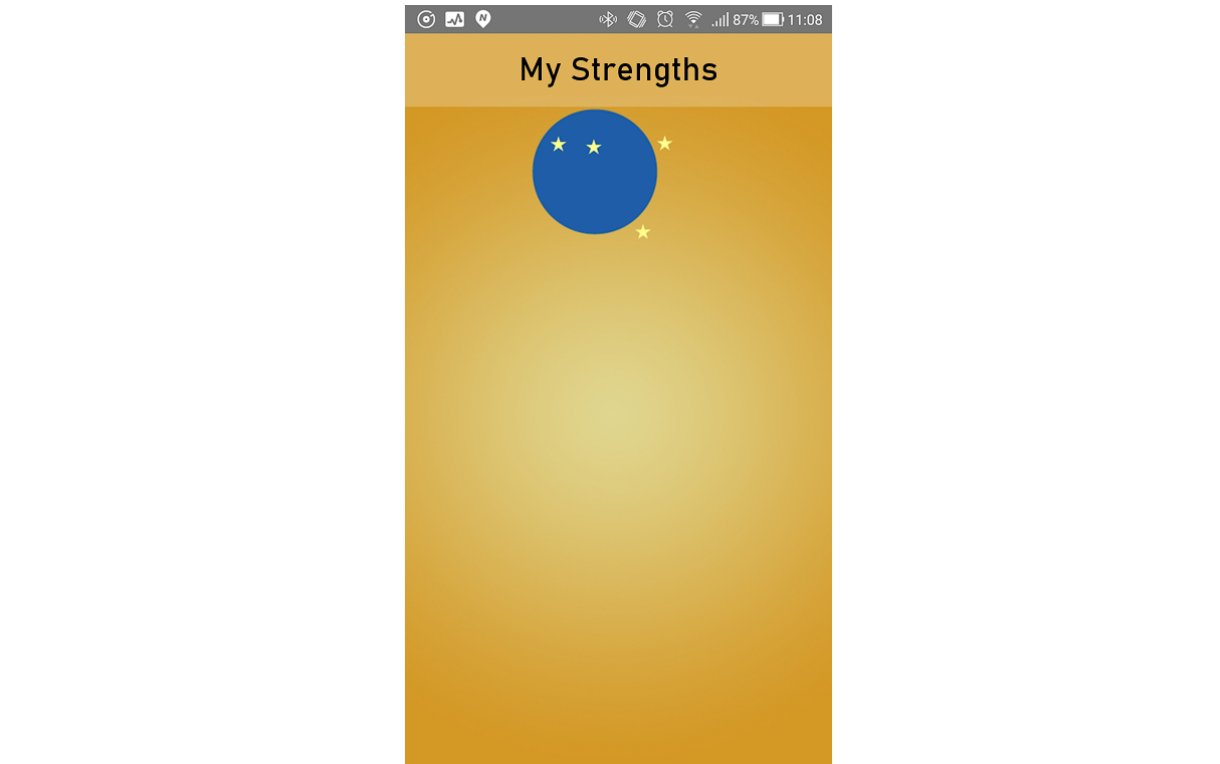
Figure 8. Screenshot of first strengths